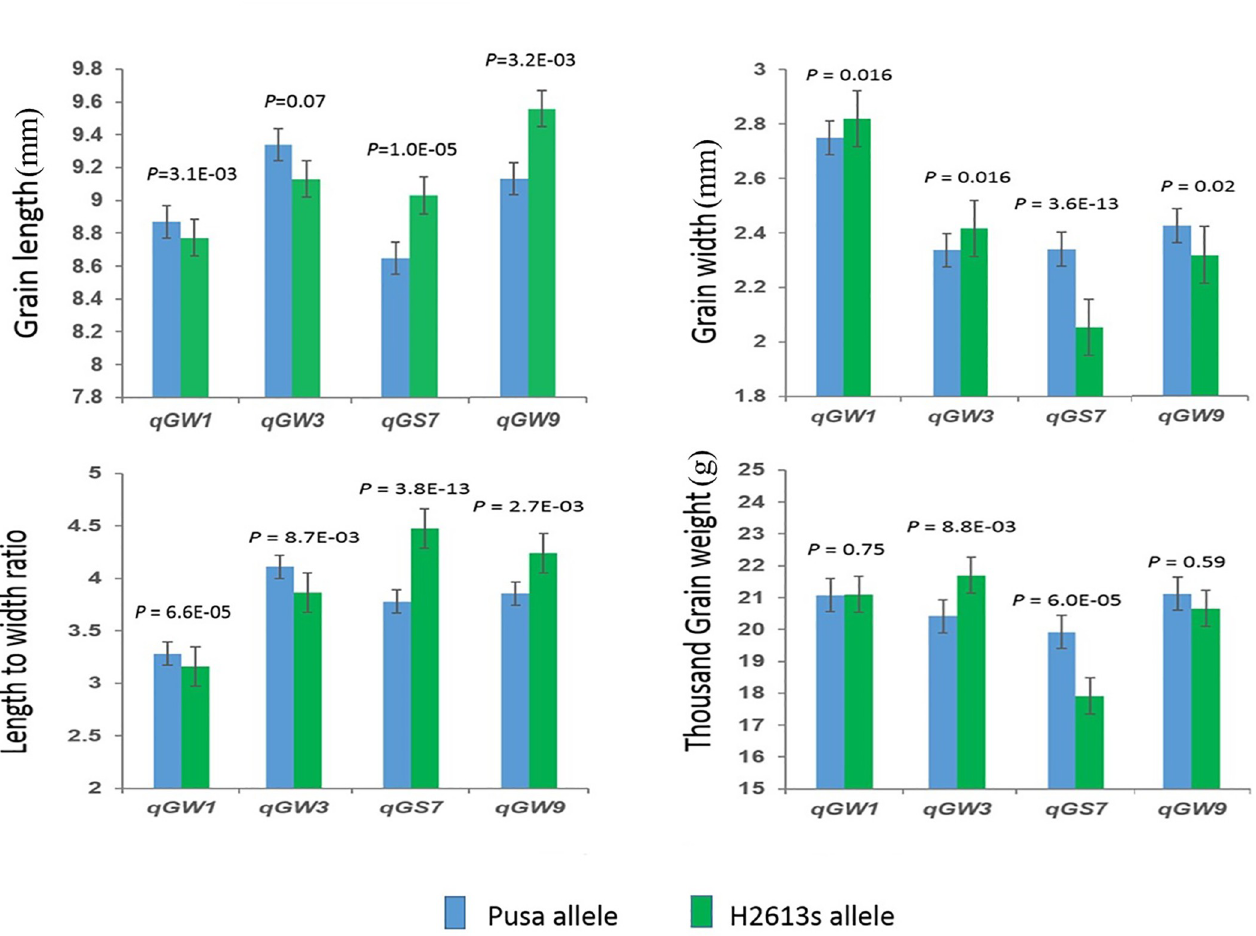
Fig 4. Genetic effects of qGW1 , qGW3 , qGS7 , and qGW9 on grain length, grain width, grain length-to-width ratio, and thousand-grain weight. The BC 1 F 6 residual heterozygous line populations of each QTL were analyzed to validate the genetic effects of these QTLs. Blue bars represent alleles from pusa, Green bars represent alleles from H2613s. Error bars are based on standard deviation of each genotype. P -values based on two-tailed t-test.